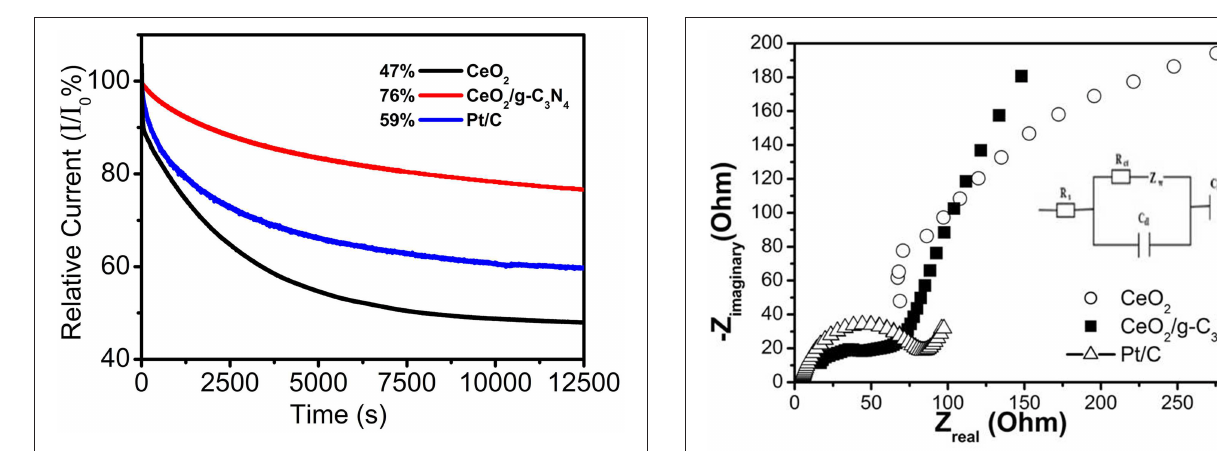
FIGURE 8 | (Current–time) chronoamperometric responses for ORR on CeO 2, CeO